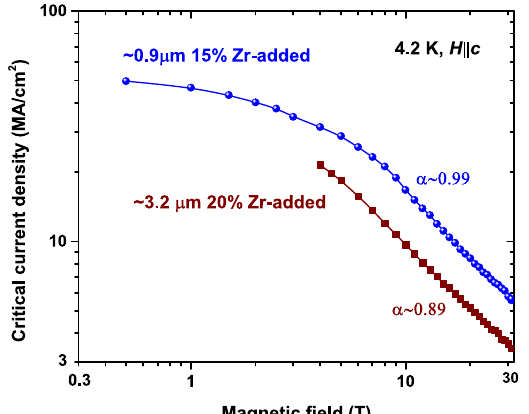
Figure 5. Comparison of J c ( H || c ) at 4.2 K and H up to 31.2 T of the ~3.2 μ m thick, 20% Zr-added, and ~0.9 μ m thick, 15% Zr-added REBCO film. The ~3.2 μ m thick film shows not only lower J c but also lower exponent